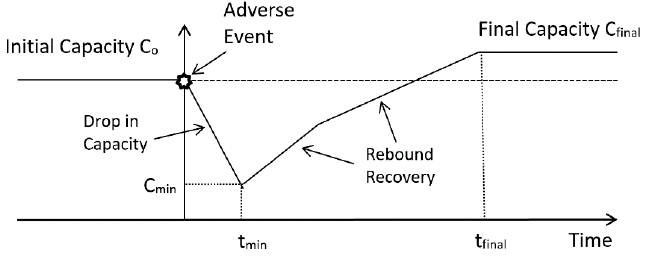
Figure 11. Variation of community capacity following a disaster or crisis (adapted from Hynes, [48]) Not to scale.